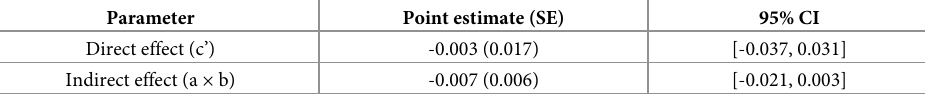
Table 2. Mediation analysis of emotion between social exclusion and WM performance in the anodal stimulation